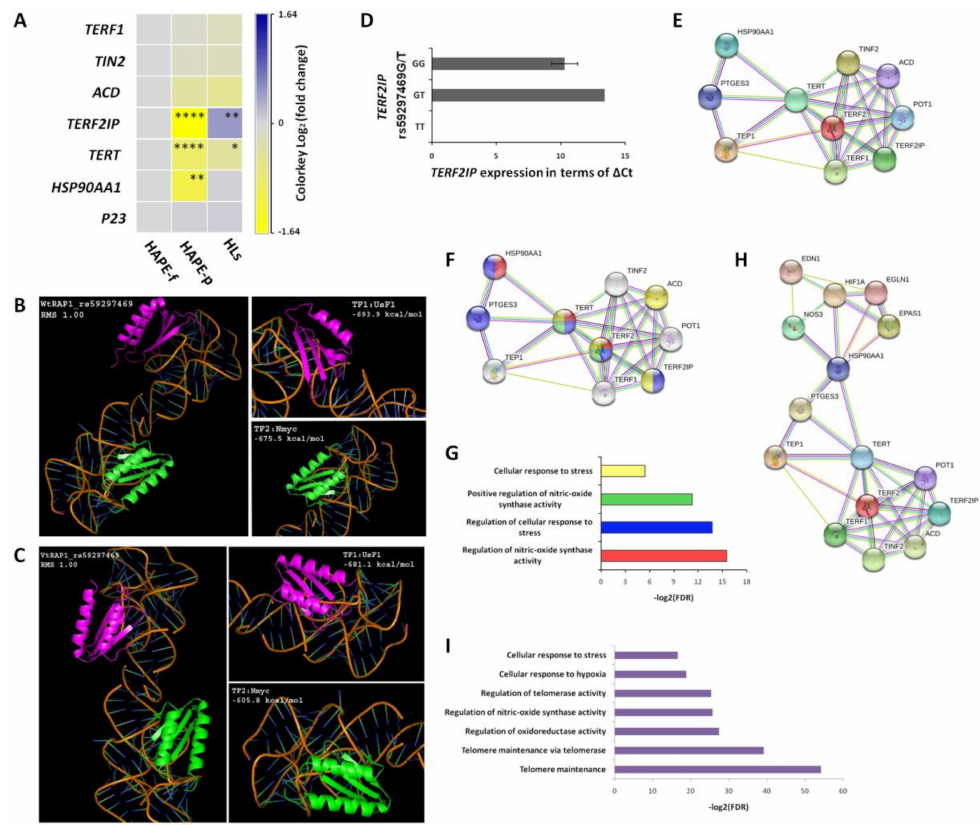
Figure 4. The gene expression, allele specificity with TFs and the genes/proteins interactions differ- entiate the physiological variations. ( A ) Heatmap of log2 fold-change value of differently expressed genes in the three study groups. TERF2IP was down-regulated by 3.1 folds in HAPE-p and up- regulated by 1.4 folds in HLs. TERT was down-regulated by 1.8 folds in HAPE-p and 1.3 folds in HLs. Further HSP90AA1 was down-regulated 2.1 folds in HAPE-p. * represents p ≤ 0.05, ** represents p ≤ 0.01 and **** represents p ≤ 0.0001. ( B ) Docking image of TFs, USF1 and N-myc on RAP1 or TERF2IP with wild type allele, rs59297469G (WtRAP1). ( C ) Docking image of TFs, USF1 and